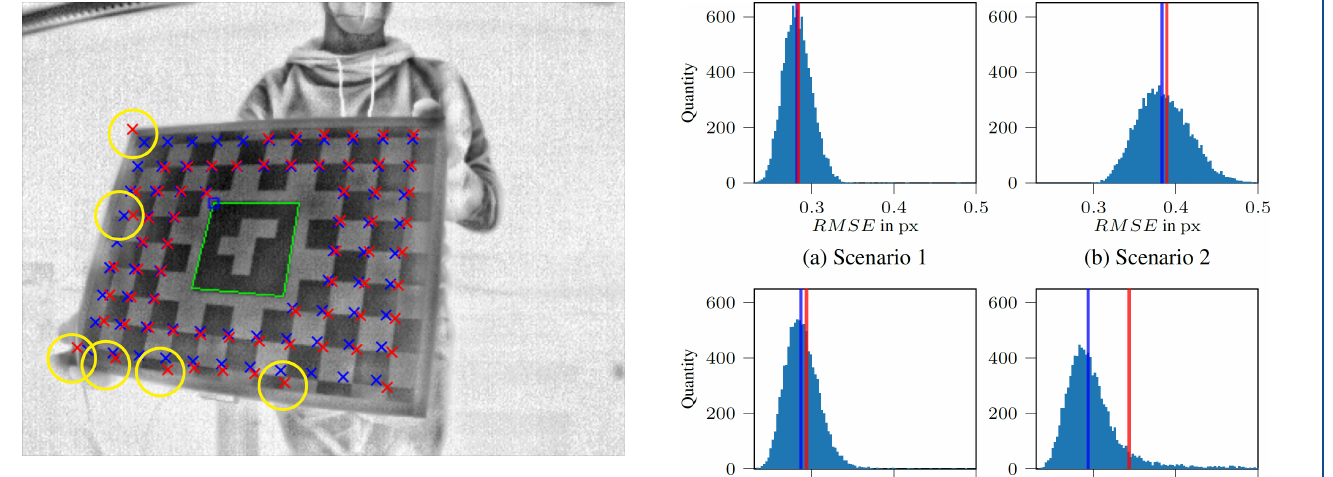
Figure 5. Incorrectly refined corners (yellow circles) due to the direct use of all target features in the first iteration step ( n u = 11, n v = 9). Reprojected corners in blue, refined corners in red.